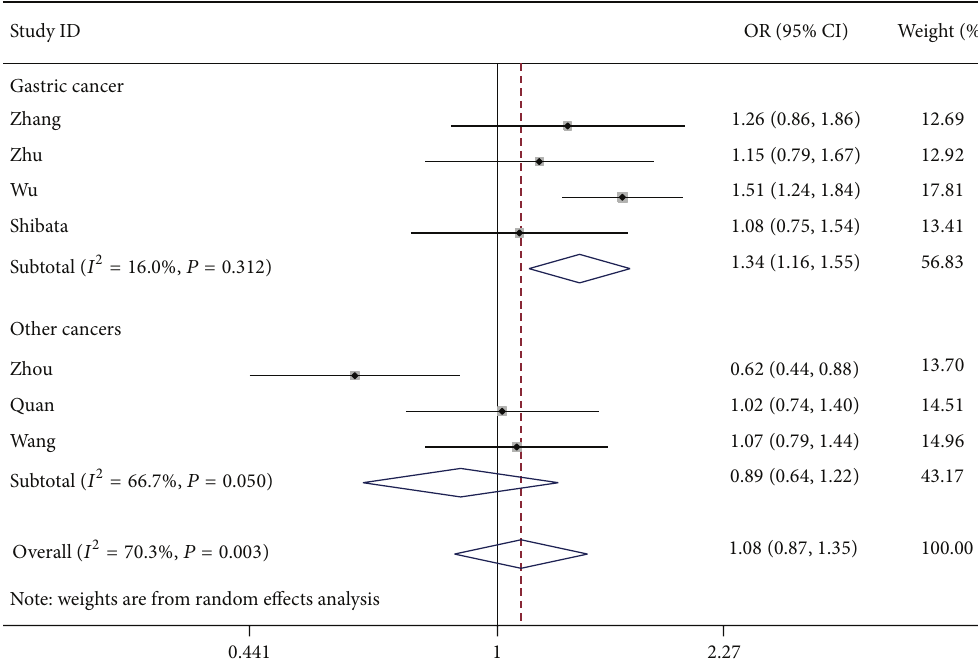
Figure 3: OR and 95% CIs for the association between IL-17F rs763780T > C polymorphisms and cancer risk in TC + CC versus TT model.